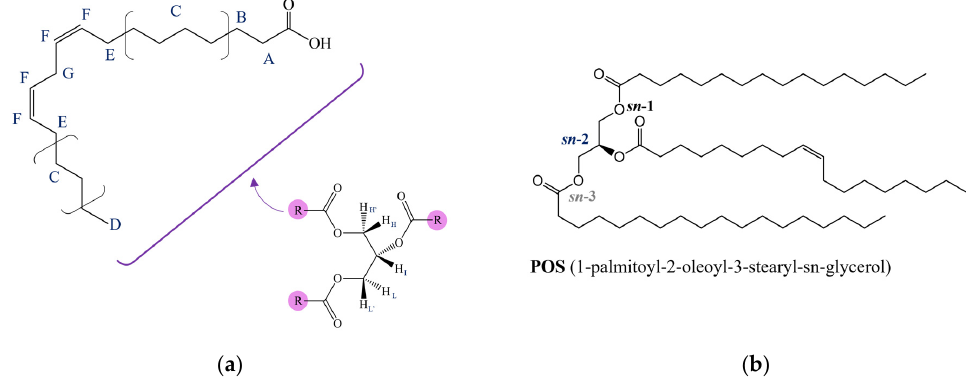
Figure 1. ( a ) General structure and proton nuclei labelling of molecular fragments in triacylglicerols (TAGs); ( b ) molecular structure of POS (1-palmitoyl-2-oleoyl-3-stearyl-sn-glycerol), the common SUS-type TAG recognized in CB.